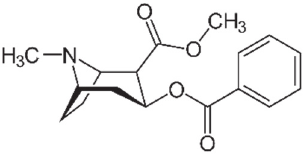
Figure 9. Chemical structure of cocaine. Formula: C 17 H 21 NO 4.